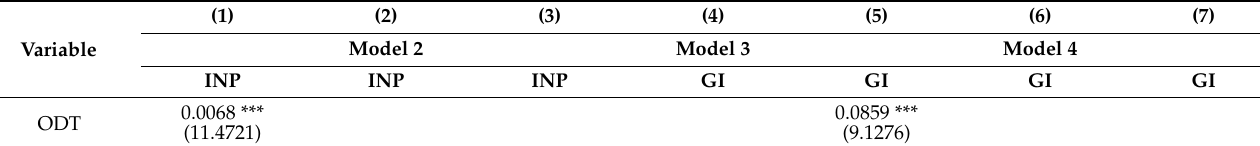
Table 4. Test results of transmission mechanism of R&D